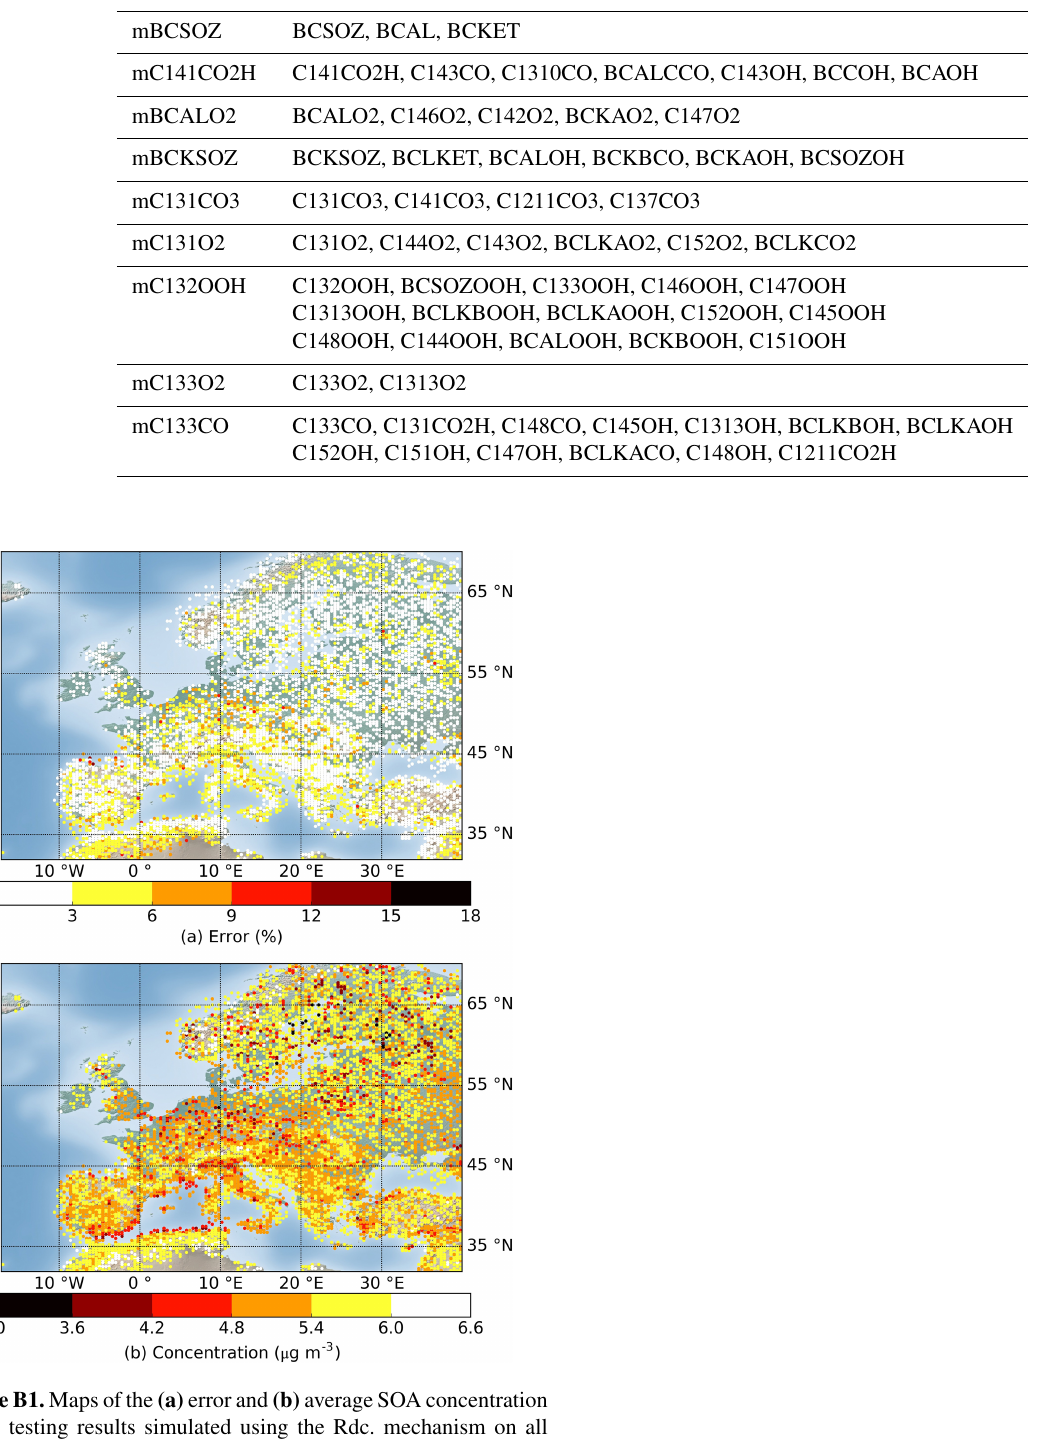
Table B3. The new surrogates in the Rdc. mechanism and the corresponding lumped species in the original MCM mechanism. Notice that the Rdc. surrogates may also go through other reductions (i.e., jumping, replacement, and removal) that do not affect their molecular structures. Rdc. surrogate